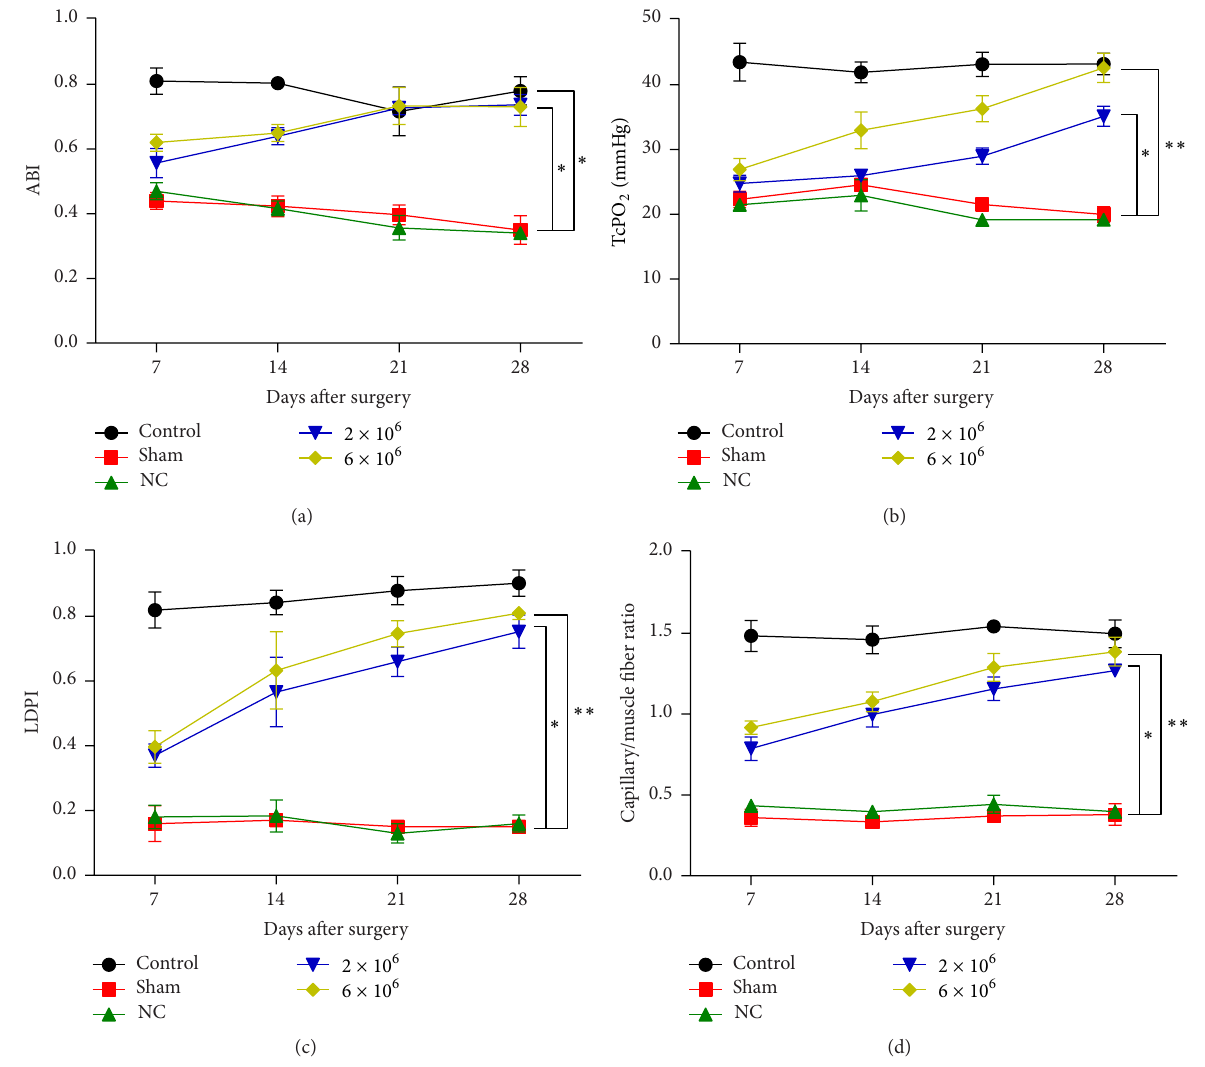
Figure 3: UC-MSCs relieved hindlimb ischemia. (a) ABI, (b) TcPO 2 , (c) LDPI, and (d) capillary/muscle fiber ratio were increased after injection of UC-MSCs. Data are presented as means ± SD from three independent experiments. ∗ represents 𝑝 < 0.05 and ∗∗ represents 𝑝 < 0.01 of sham group versus 2 × 10 6 or 6 × 10 6